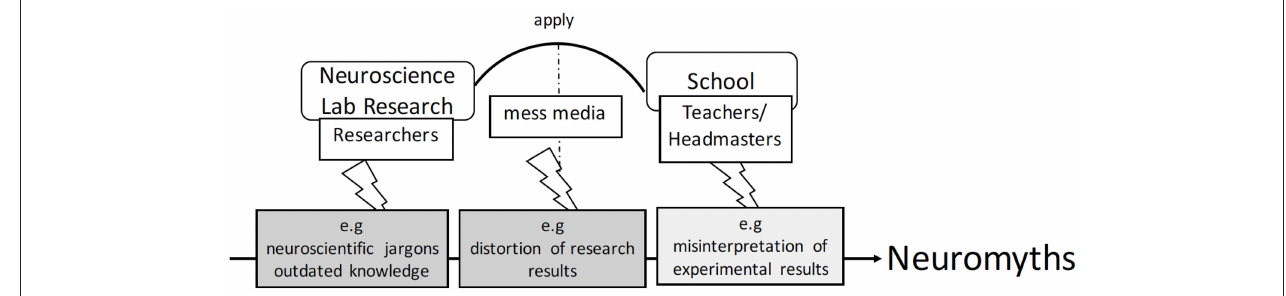
FIGURE 1 | Neuroscientists, the mass media and educators might all contribute to neuromyths.